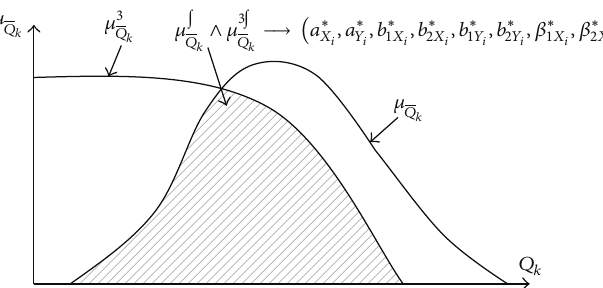
Figure 2: Graphic illustration of a choice of optimum adjusting